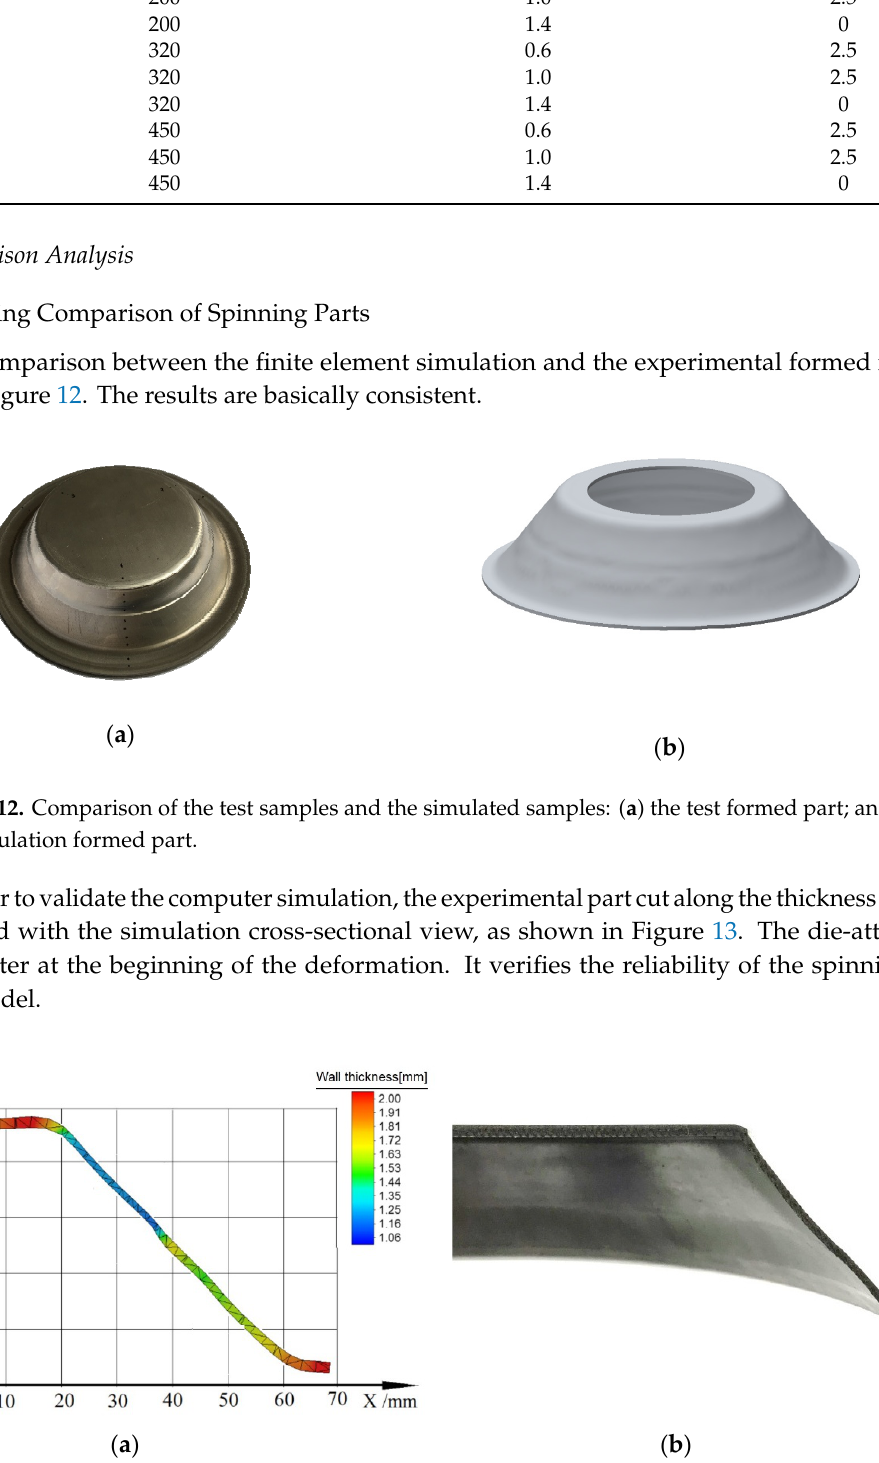
Table 4. Process parameters for the spin ‐ formed conical.